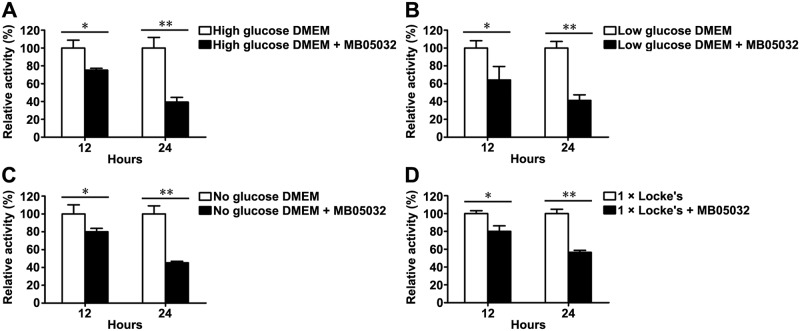
Native CsFBPase activity inside C. sinensis adults with or without MB05032 treatment.Adult flukes were respectively maintained on high, low, and no glucose DMEM (A, B, and C), as well as 1 × Locke’s (D) with or without the addition of MB05032. Native CsFBPase activity was measured at 12 and 24 h of feeding. Differences between two groups were evaluated by student’s t test. *P < 0.05 and **P < 0.01 were represented as statistical significance.